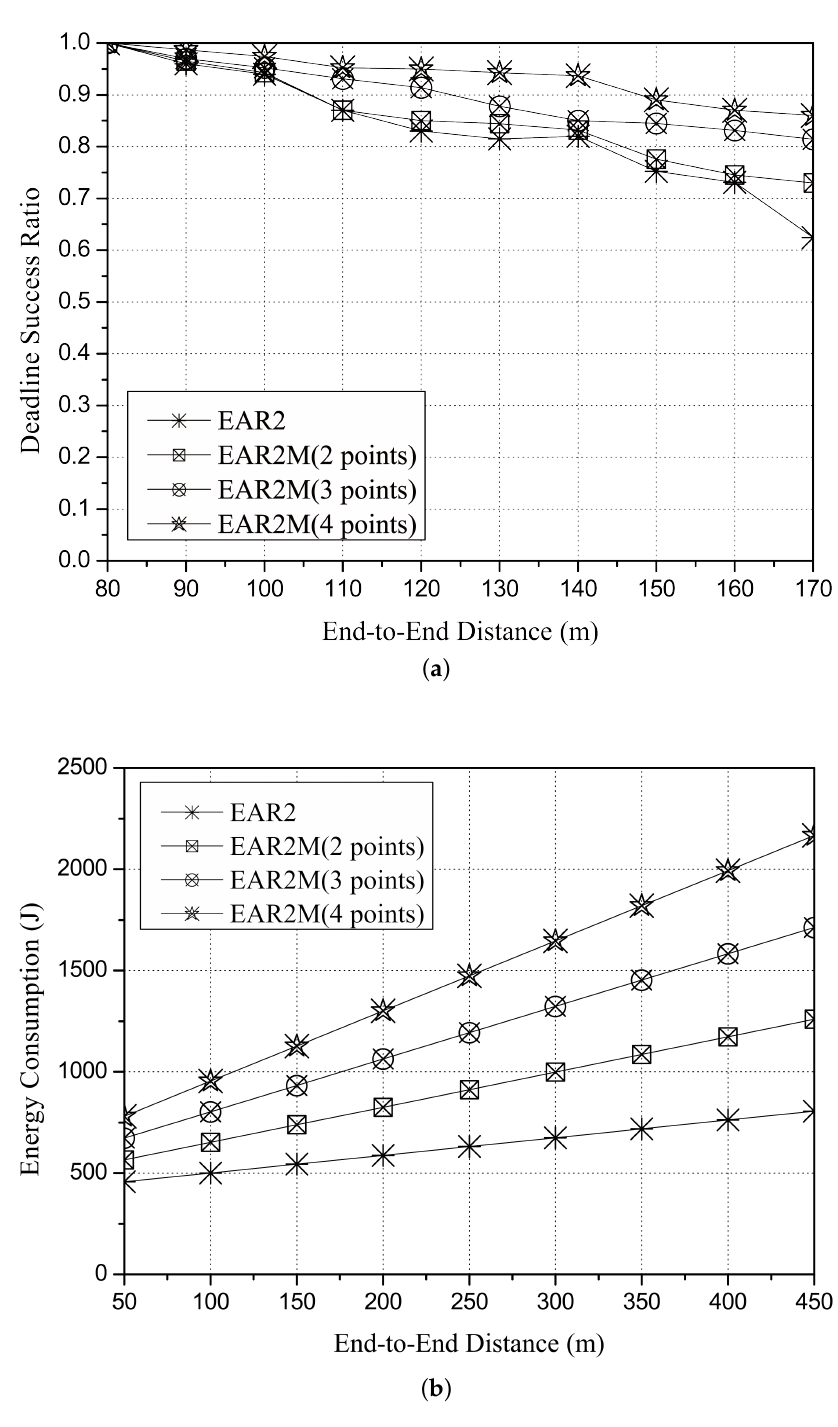
Figure 8. Performance comparison of EAR2 with EAR2M according to end-to-end distance: ( a ) dead- line success ratio and ( b ) energy